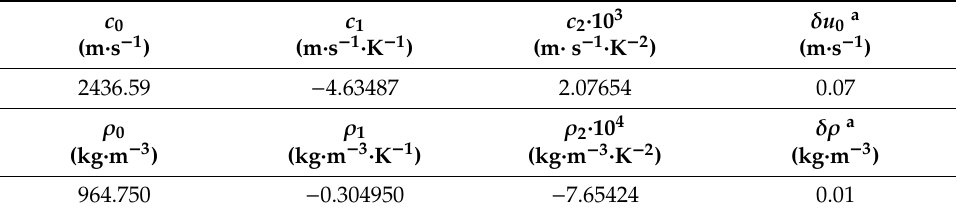
Table 3. Coe ffi cients of polynomial (1) for the speed of sound and density.